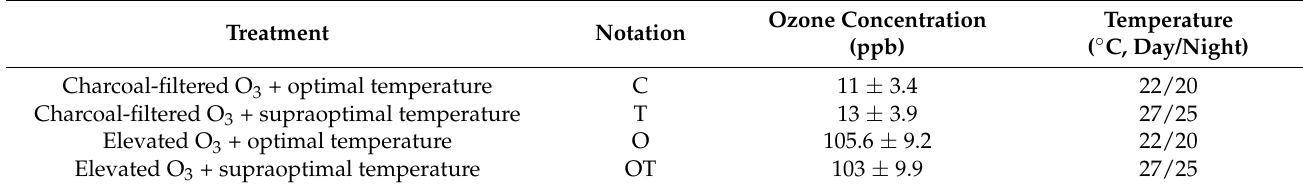
Table 1. Controlled environmental conditions in each treatment chamber in the experiment.